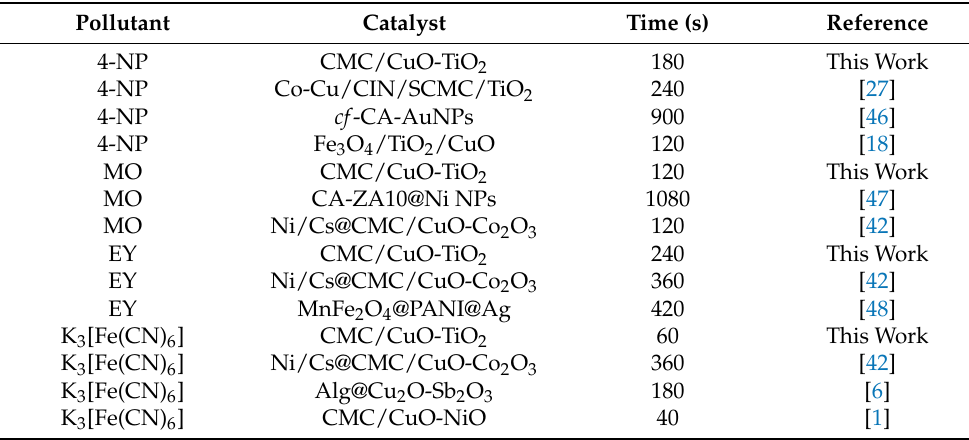
Table 1. Comparison of the catalytic reduction of 4-NP, MO, EY, and K 3 [Fe(CN) 6 ] by using CMC/CuO- TiO 2 beads in the presence of NaBH 4 with other reported